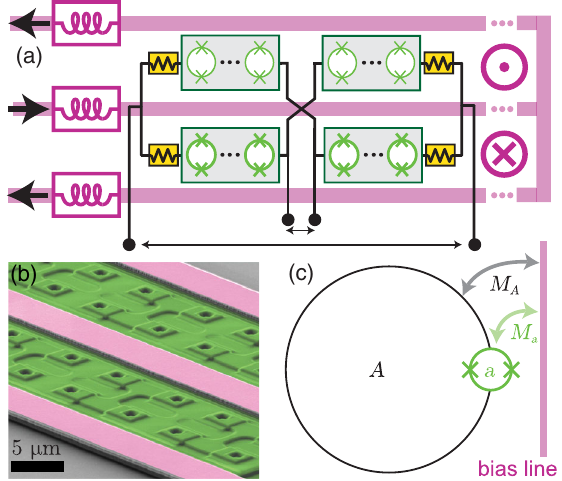
FIG. 11. (a) Schematic showing the position of normal metal resistors in the inductive bridges and the routing of a quadrupole- source bias line that couples strongly to the SQUIDs it encloses and weakly to surrounding loops of the circuit. (b) False-color scanning electron microscope image showing two adjacent SQUID arrays (green) and the microstrip lines (pink) that flux bias them. (c) Schematic illustrating the challenge of coupling a bias line strongly to a small SQUID loop while coupling it weakly to a larger circuit